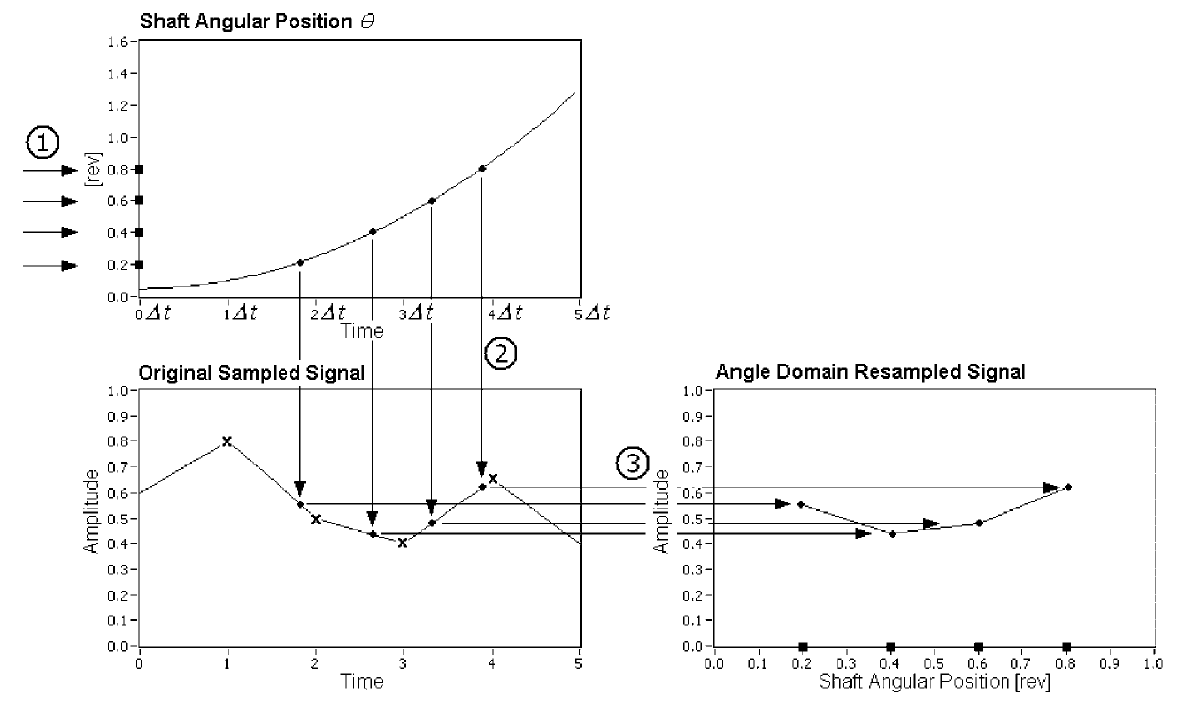
Fig. B1. Traditional method. Key: x = original sampled data, • = resampled data, and (cid:4) = constant angle